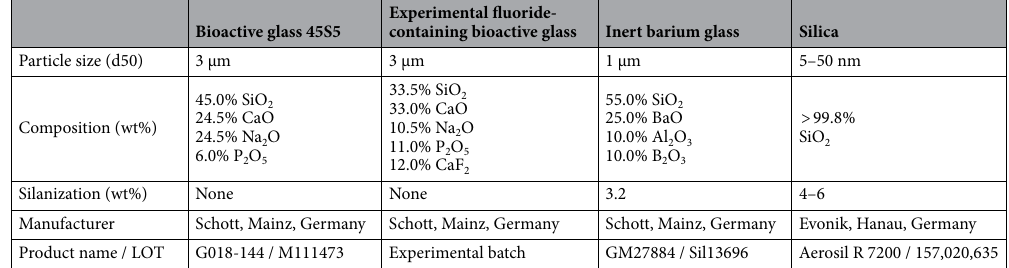
Table 1. Bioactive glass and reinforcing fillers used in experimental composites.